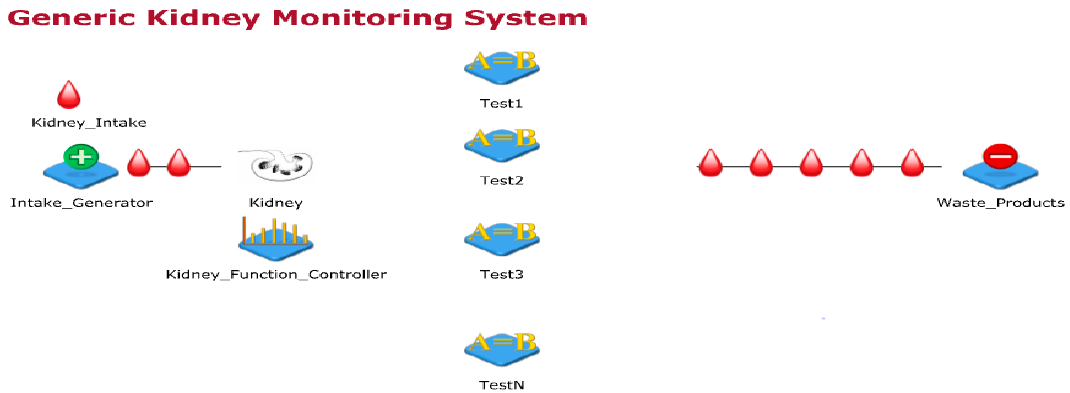
Figure 9. Generic kidney monitoring system in execution.